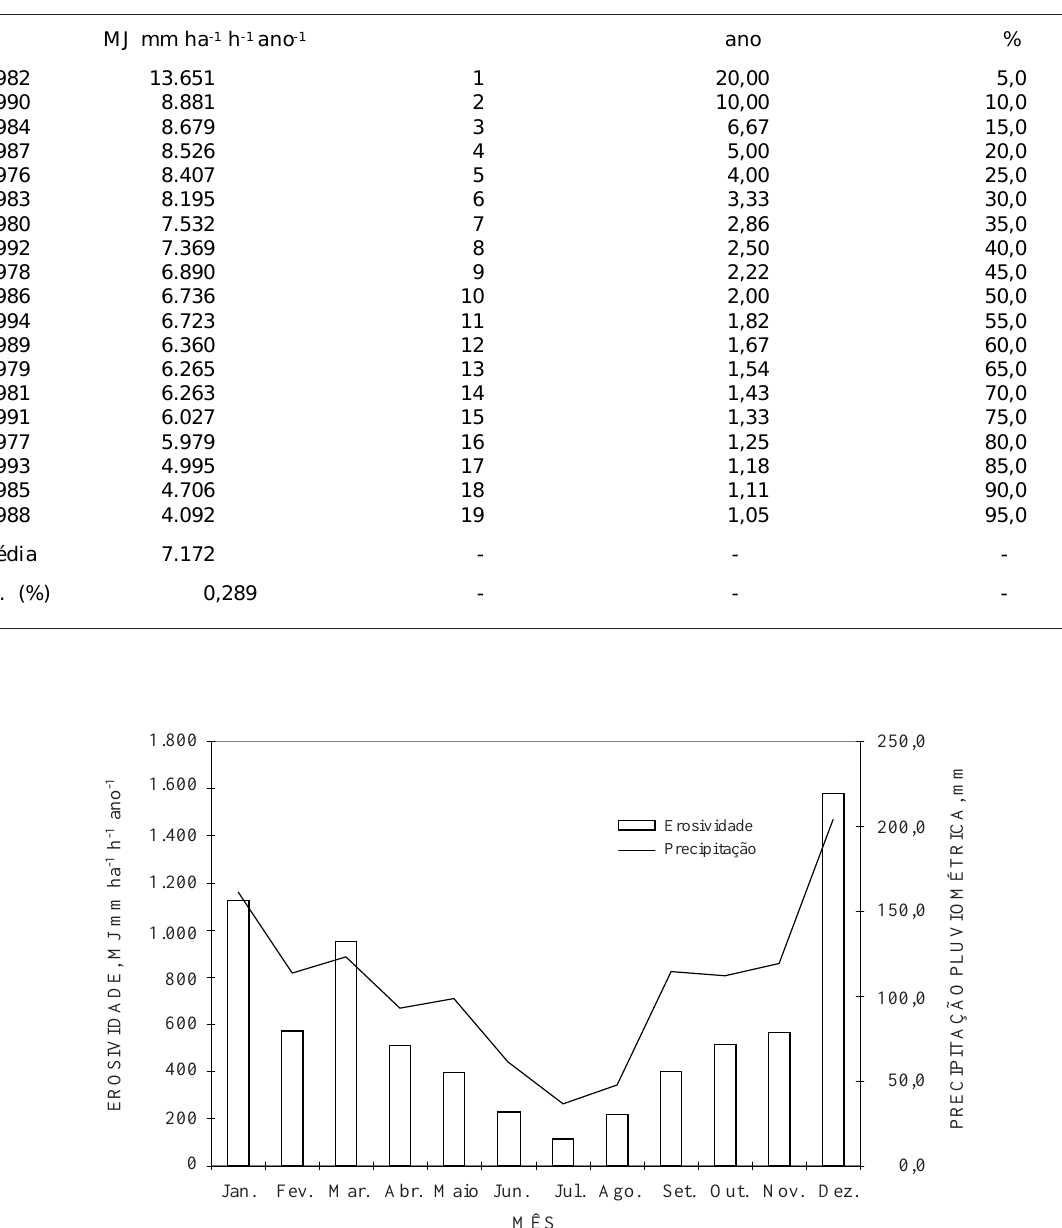
Figura 1. Distribuição da erosividade (EI Sampaio (SP) no período de 1976 a